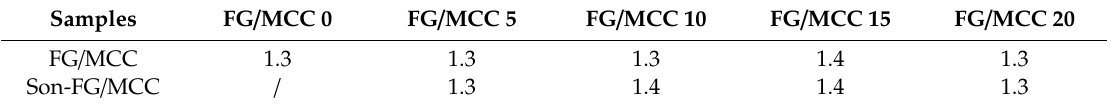
Table 1. The density (g / cm 3 ) of the FG / MCC films with di ff erent MCC